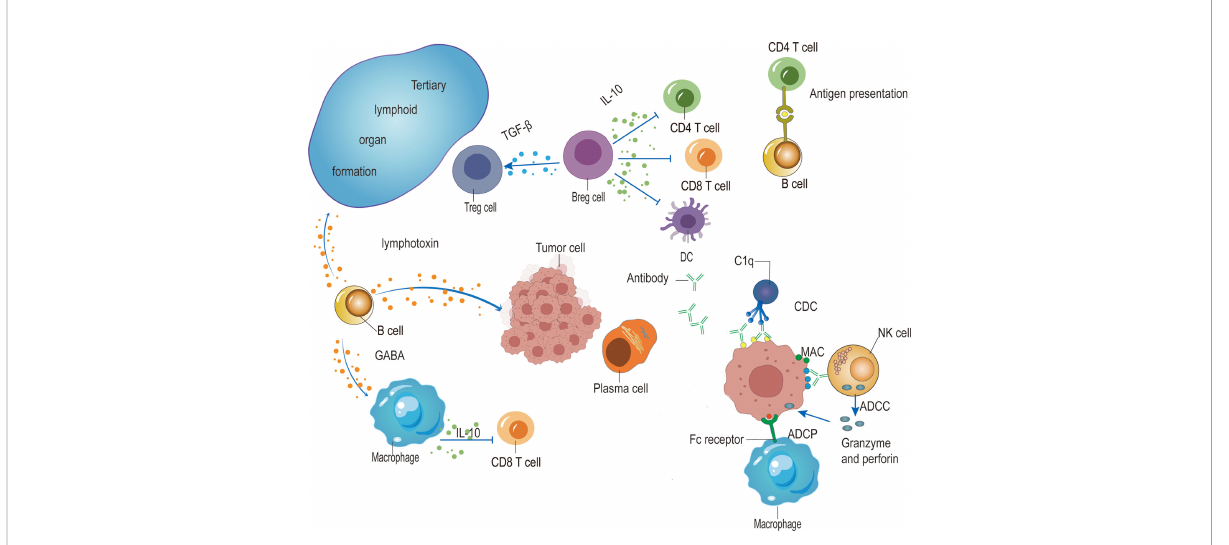
FIGURE 1 The role of B cells in tumor immunity. The antibodies produced by plasma cells induce ADCC mediated by NK cells, ADCP by macrophages, and CDC mediated by C1q, which target and kill tumor cells. IgA-expressing Breg cells dampen anti-tumor immunity by secreting anti- in fl ammatory cytokines such as IL-10 and TGF- b to suppress CD4 + T cells, CD8 + T cells and dendritic cells (DCs), and facilitate Treg cells. B cells also promote anti-tumor immunity by presenting antigen to CD4 + T cells and further interacting with activated T cells to induce TFH cells, thus promoting the function of CD8 + T cells. In addition, the production of lymphotoxin from B cells enhances anti-tumor immunity by facilitating tertiary lymphoid organ formation while promoting tumor growth by the induction of angiogenesis. Moreover, B cells produce GABA to impair anti-tumor immunity by facilitating IL-10-producing